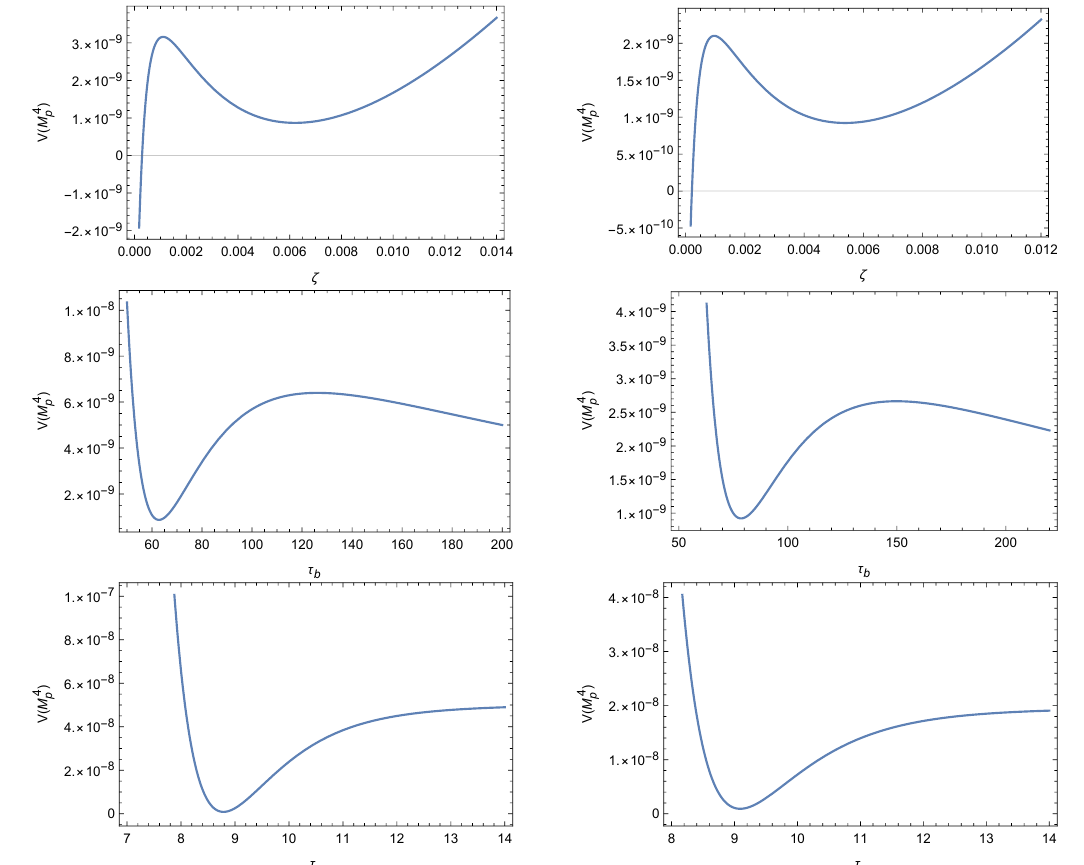
Figure 6. Plots of the potential (4.11) in each of the 3 directions ( ζ, τ b , τ s ) , for the parameter set in table 2, around the minimum (left) and the saddle point (right).